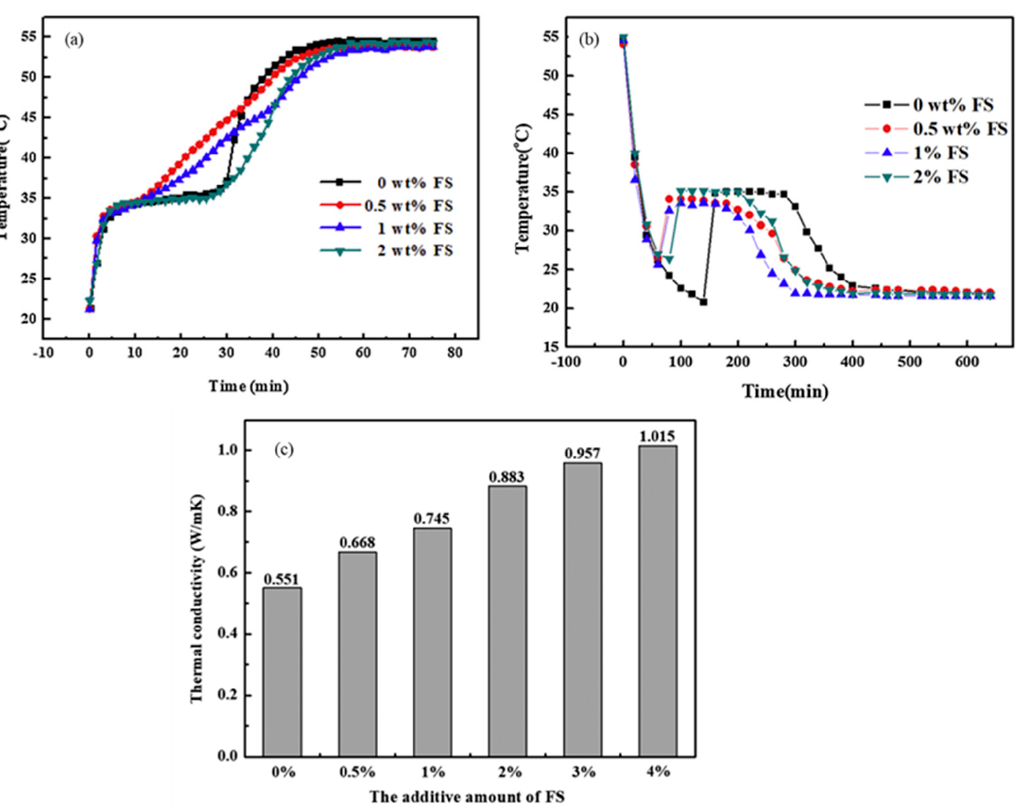
Figure 10. ( a ) Melting cycle; ( b ) freezing cycle; and ( c ) TC of the DHPD samples [77]. Important observations from existing PCM + GTA + NA studies are consolidated in Table 2. Overall, the inclusion of a GTA alone helped prevent seepage and provided better stability for the PCMs, with some even reducing the SCD notably. Additionally, the NT seeding along with a GTA in the PCM eliminated the SCD and ensured crystallization with reduced energy. However, there was a reduction in LH and TC with increased viscosity, which limited the loading level of the GTA. Additionally, it does not hasten the melting/solidification process. Therefore, further studies need to be conducted to address these issues through the addition of NPs along with a GTA into the PCMs. Table 2. Notable observations from the existing PCM + NT+ GTA studies. Observations Application Approach